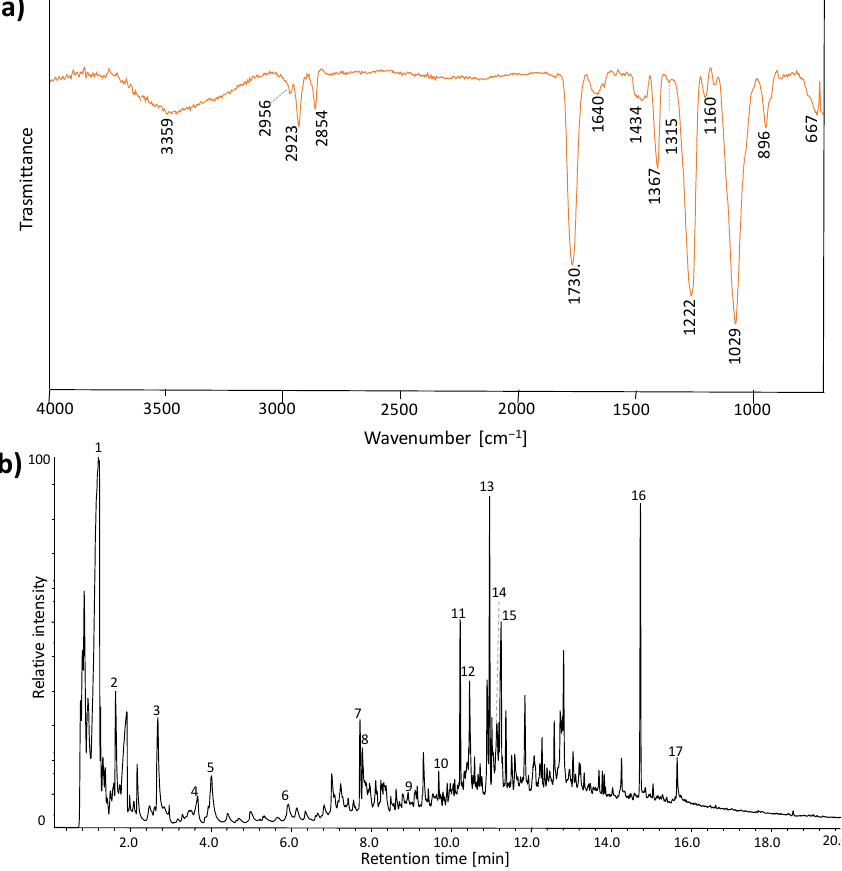
Figure 6. ( a ) ATR-FTIR spectrum and ( b ) Py-GC/MS pyrogram of sample P. Table 3. Band assignment for the ATR-FTIR spectrum of sample P reported in Figure 6a. Wavenumber (cm −1 )